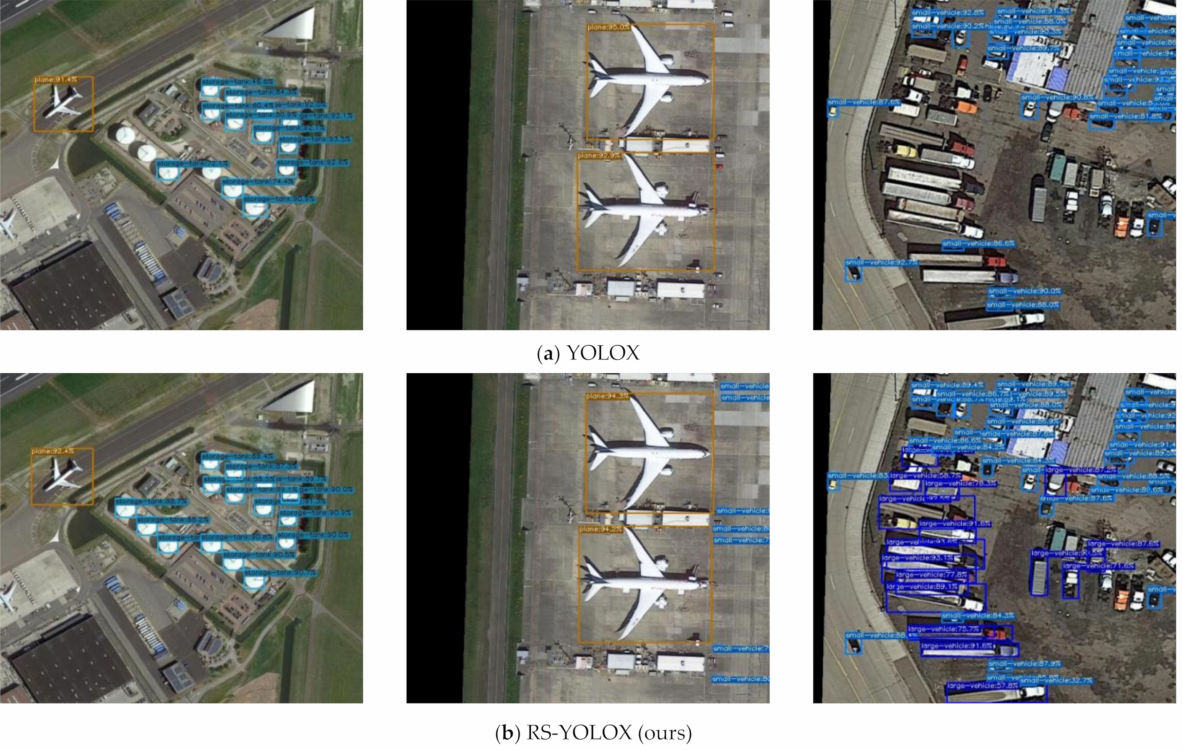
Figure 11. Comparison of detection results of YOLOX and RS-YOLOX on the DOTA-v1.5